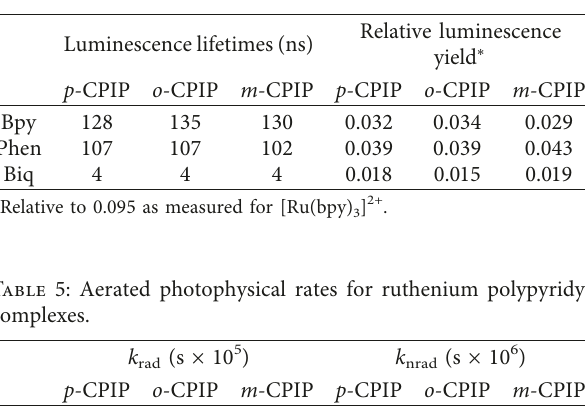
Figure 8: Normalised UV/Vis (a) and luminescence (b) spectra of [Ru(phen) Table 4: Luminescence data for ruthenium complexes aerated in acetonitrile.